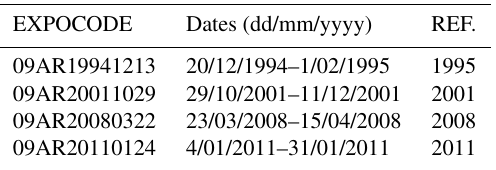
Table 1. Repeats of the GO-SHIP SR03 line on board the Aurora Australis from 1995 to 2011 with the expocode from GLODAPv2 database. Dates (dd/mm/yyyy)